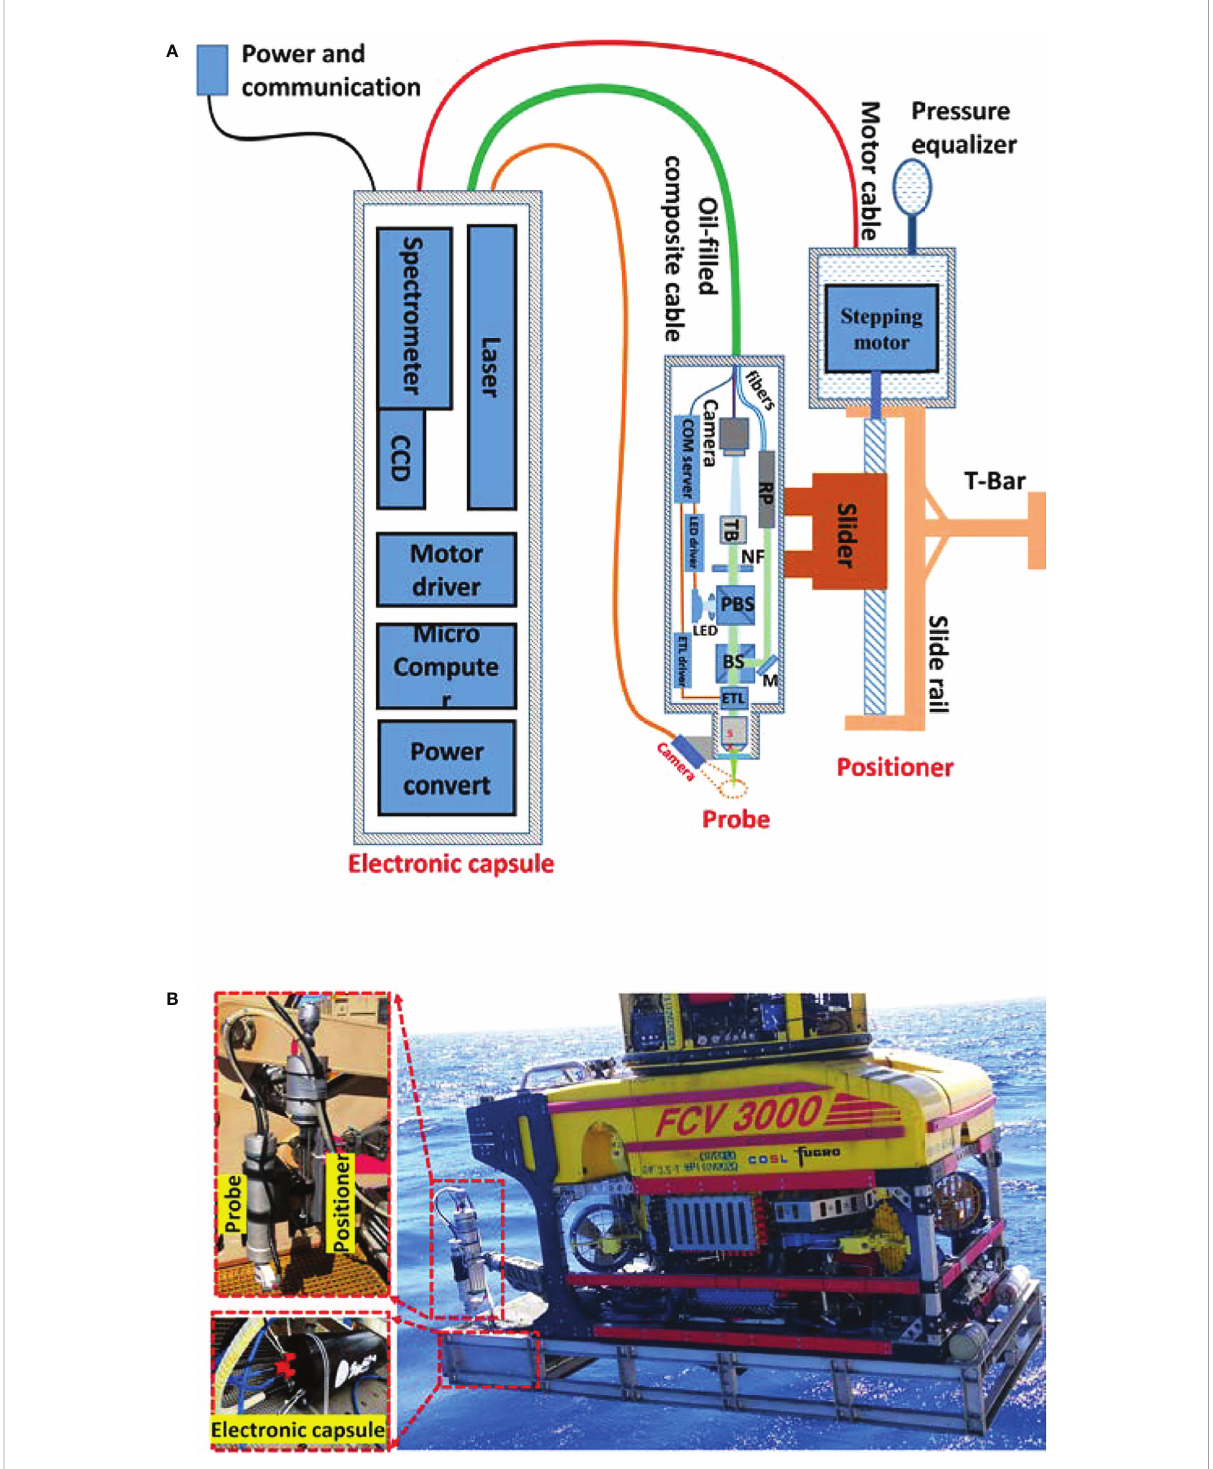
FIGURE 1 System composition and its deployment in the sea trial. (A) The schematic diagram of MICROcean. (B) The deployment of the MICROcean in the sea